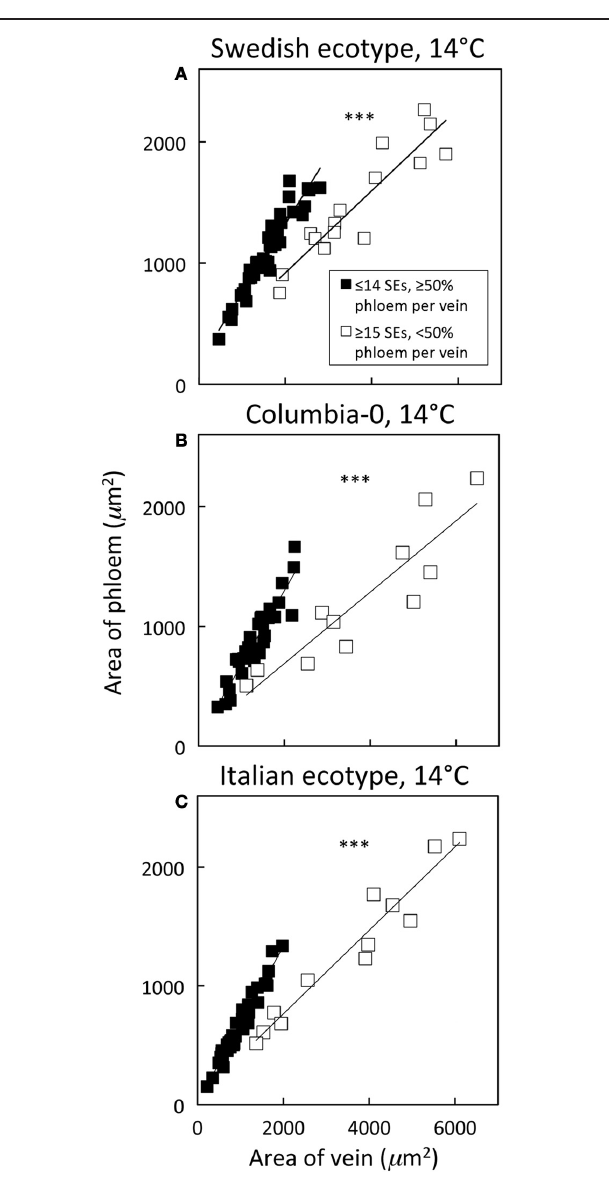
FIGURE 7 | Relationship between phloem cross-sectional area (all phloem cells combined) and total vein cross-sectional area for individual second-, third-, and fourth-order veins from the A. thaliana Swedish (A), Col-0 (B), and Italian (C) ecotypes grown at 14 ◦ C under 400 µ mol photons m − 2 s − 1 . Individual veins ( n = 52, Swedish; n = 56, Italian; n = 46, Col-0) were segregated by sieve element (SE) number and ratio of phloem area/vein area into veins containing ≤ 14 SEs and phloem area/vein area ≥ 0.5 (black squares; putative minor loading veins) or ≥ 15 SEs and phloem area/vein area < 0.5 (open squares; second order veins). Linear regression lines shown for each segregated group of veins ( ≤ 14 SEs or ≥ 15 SEs), and statistically significant differences in slope and intercept (ANCOVA) between regression lines is indicated ( ∗∗∗ = P < 0 . 001). Linear regression analyses for each line are ( A ) y = 0 . 57 x + 184, R 2 = 0 . 91, and P < 0 . 001 (black squares) and y = 0 . 34 x + 243, R 2 = 0 . 85, and P < 0 . 001 (open squares), ( B ) y = 0 . 62 x + 60, R 2 = 0 . 87, and P < 0 . 001 (black squares) and y = 0 . 30 x + 94, R 2 = 0 . 82, and P < 0 . 001 (open squares), and ( C ) y = 0 . 66 x + 15, R 2 = 0 . 96, and P < 0 . 001 (black squares) and y = 0 . 35 x + 60, R 2 = 0 . 94, and P < 0 . 001 (open